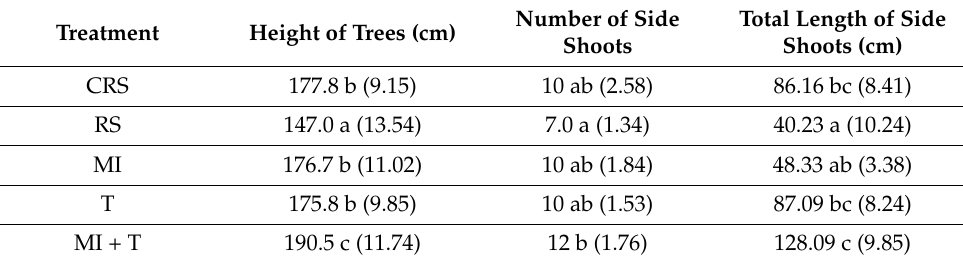
Each parameter was individually analyzed statistically. Means marked with the same letters do not differ significantly at α = 0.05. Values in brackets represent standard deviation.